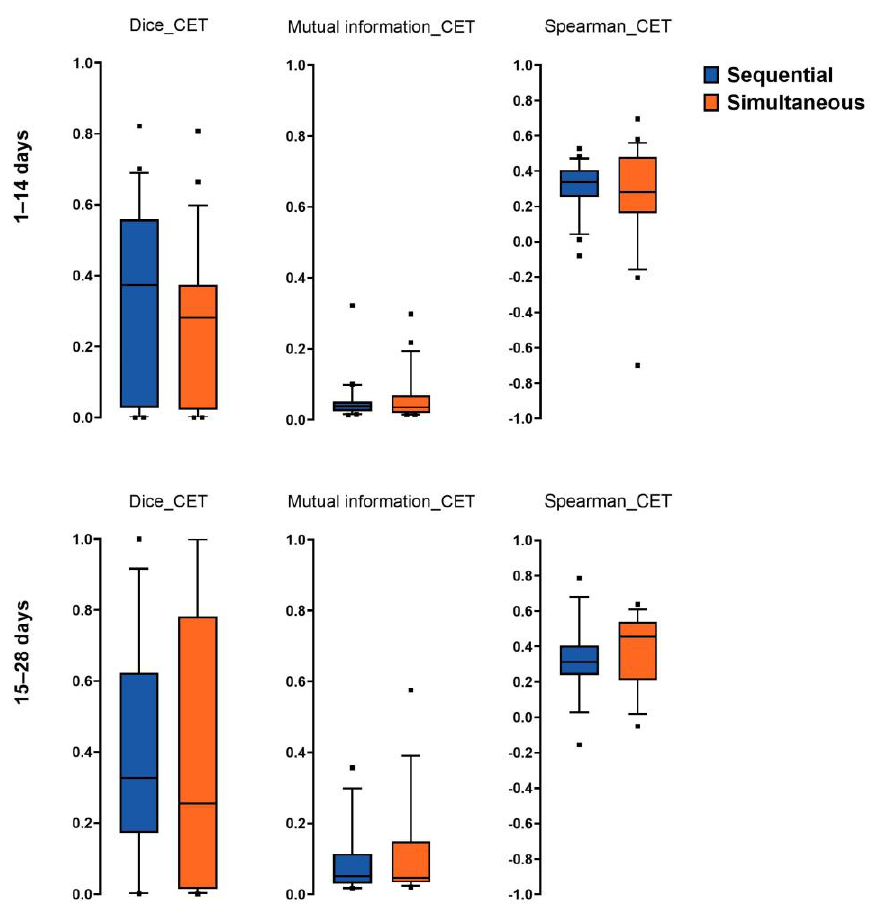
Figure 2. Dice score (Dice), mutual information and Spearman correlation (Spearman) of contrast- enhancing tumor areas (CET). No significant difference was observable in the 90th percentile between sequential (blue) and simultaneous PET/MRI (orange) image acquisition for group 1 (1–14 days; n = 22) as well as for group 2 (15–28 days; n = 14). Dots denote outliers.